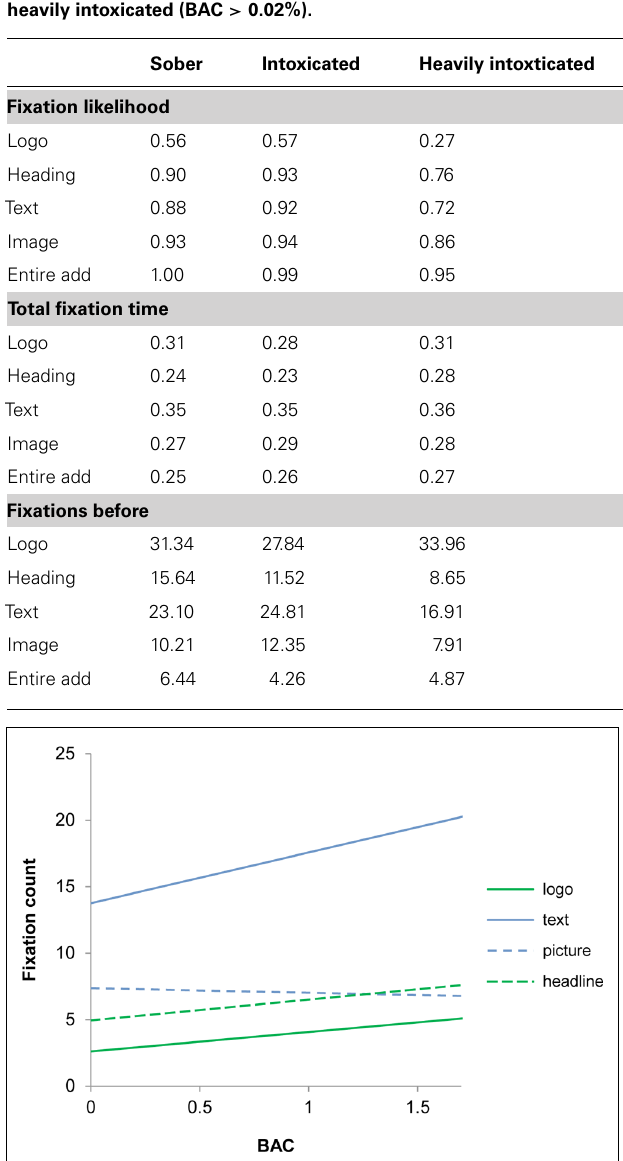
FIGURE 2 | Effects of blood alcohol concentration on fixation count to ad elements.